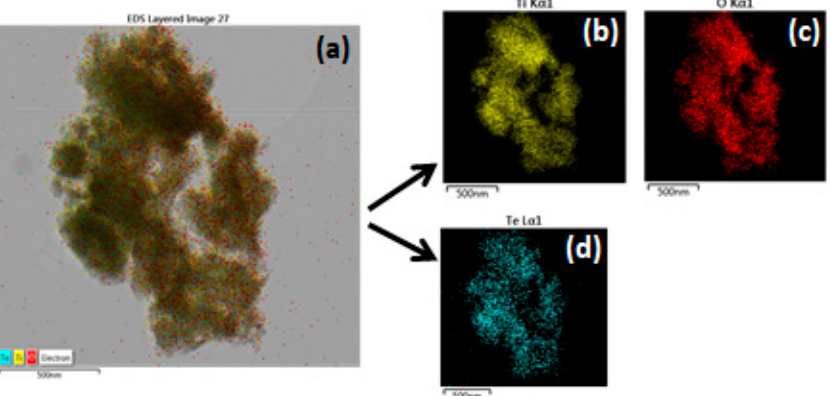
Figure 6. ( a ) Integral XEDS-STEM composition map from selected area of sample 90TiO 2 /10TeO 2 heat treated at 600 °C; ( b ) composition map of Ti; ( c ) composition map of O; ( d ) composition map of Te.